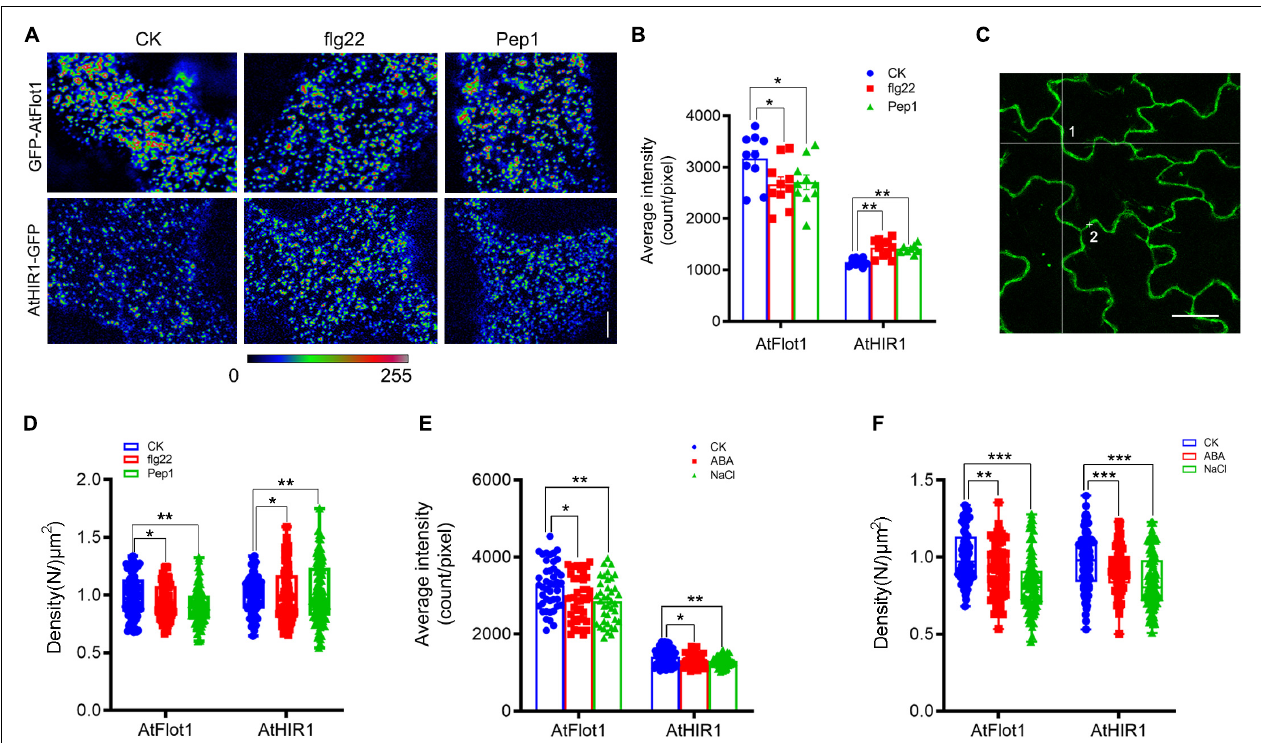
FIGURE 4 | Distribution of GFP-AtFlot1 and AtHIR1-GFP at the PM under biotic and abiotic stresses. (A) Pseudocolor images (blue-yellow-red palette) show the fluorescence intensity of AtFlot1/AtHIR1 foci at the plasma membrane in control cells and cells treated with flg22 or Pep1 peptides for 15 min. Bar = 5 µ m. (B) Average fluorescence intensity of GFP-AtFlot1 and AtHIR1-GFP under control, flg22 and Pep1 treatments for 15 min. For each examination, at least 10 cells from each of three seedlings were examined. In each case, three biological replicates were performed. Statistical significance was determined using Student’s t -tests (* P < 0.05; ** P < 0.01). (C) Confocal images of GFP-AtFlot1 were analyzed using FCS at points 1 and 2. Bar = 10 µ m. (D) The density of GFP-AtFlot1 and AtHIR1-GFP under flg22 and Pep1 treatment was measured by FCS. For each examination, at least 30 cells from each of five seedlings were examined. In